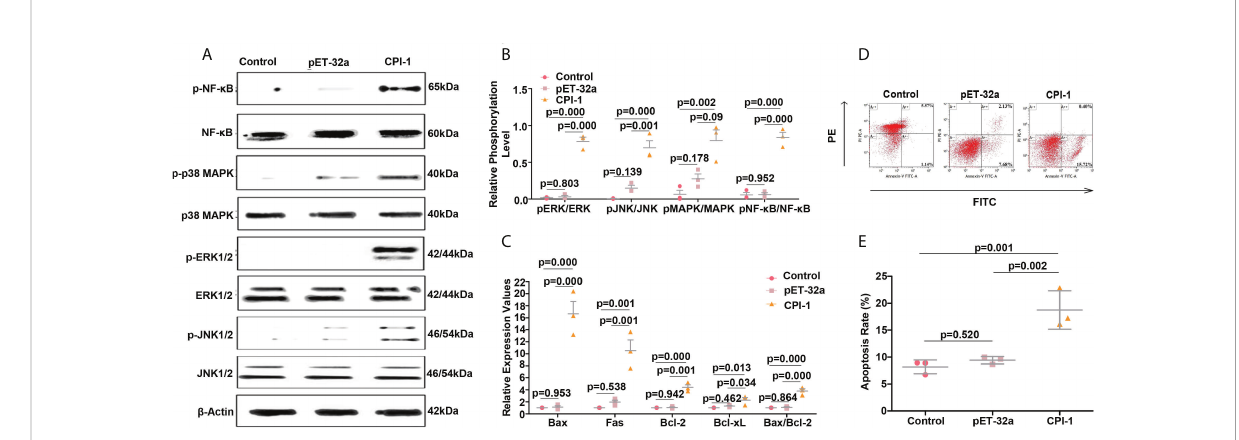
FIGURE 3 rBsCPI-1 activates the MAPK and NF- k B pathways and affects the apoptosis of MDMs. (A, B) Western blot was performed to detect the activation of the MAPK and NF- k B signaling pathways. A representative Western blot is shown in (A) , and a graph of the quanti fi ed band density is shown in (B) . (C) qPCR analysis of the transcript levels of apoptosis-related genes. (D) Apoptosis of MDMs was determined by staining with annexin V and PI using FCM. (E) The total apoptosis rate presented is representative of three independent experiments. The data are shown as the mean ± SD of 3 repetitions per